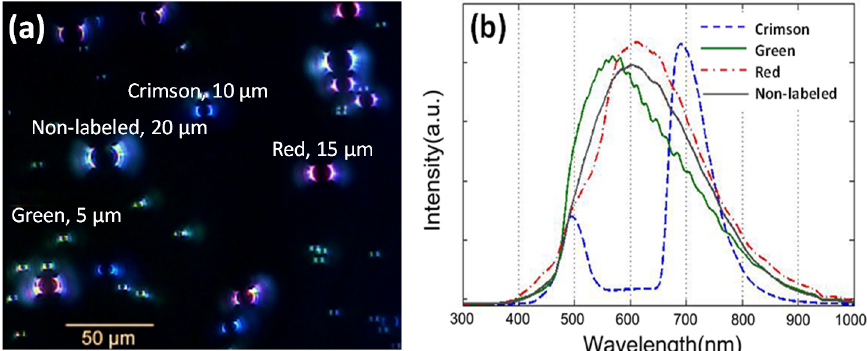
Figure 4. ( a ) Images obtained under diascopic illumination of green-labeled (5 µ m), red-labeled (15 µ m), crimson-labeled (10 µ m), and non-labeled (12 µ m) polystyrene beads. ( b ) Corresponding detected wavelength spectra. Note that the spectrum for the non-labeled particle in ( b ) was used as reference spectra and was used to calculate the fluorescent, absorbance, and side-scatter indices.